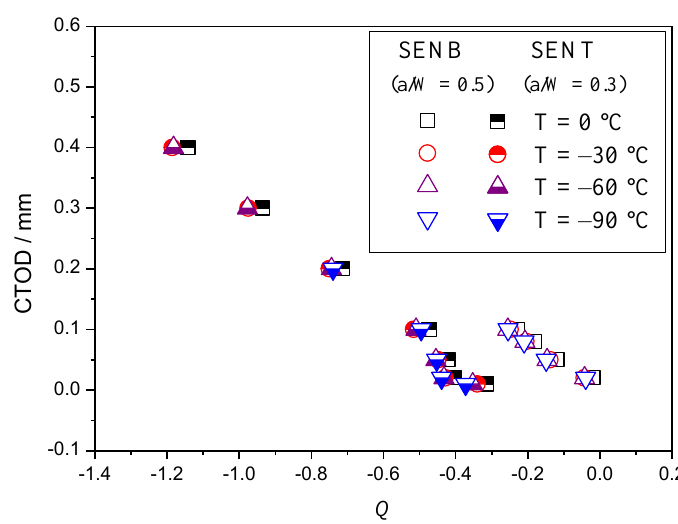
= 0 ◦ C, − 30 ◦ C, − 60 ◦ C, and − 90 ◦ C.